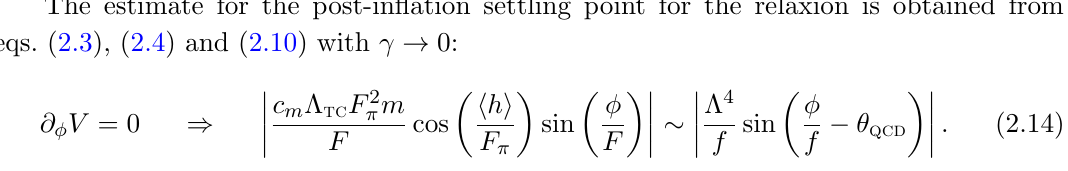
Post slope-drop, the relaxion will only roll a distance point (see (cid:12)gure 2), so the changes in sin ( (cid:30)=F ) and in